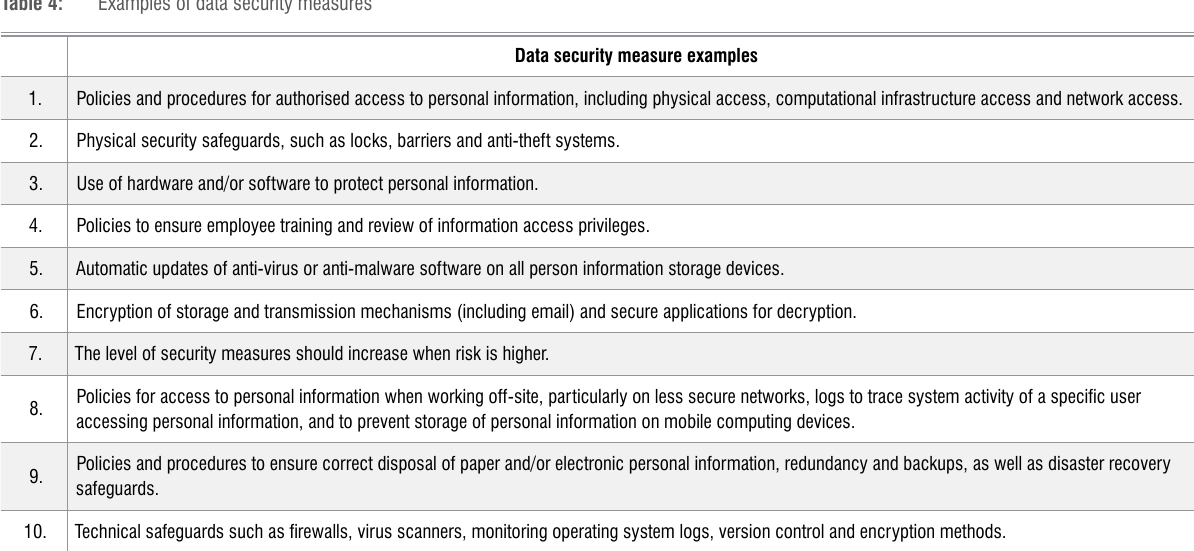
Examples of data security